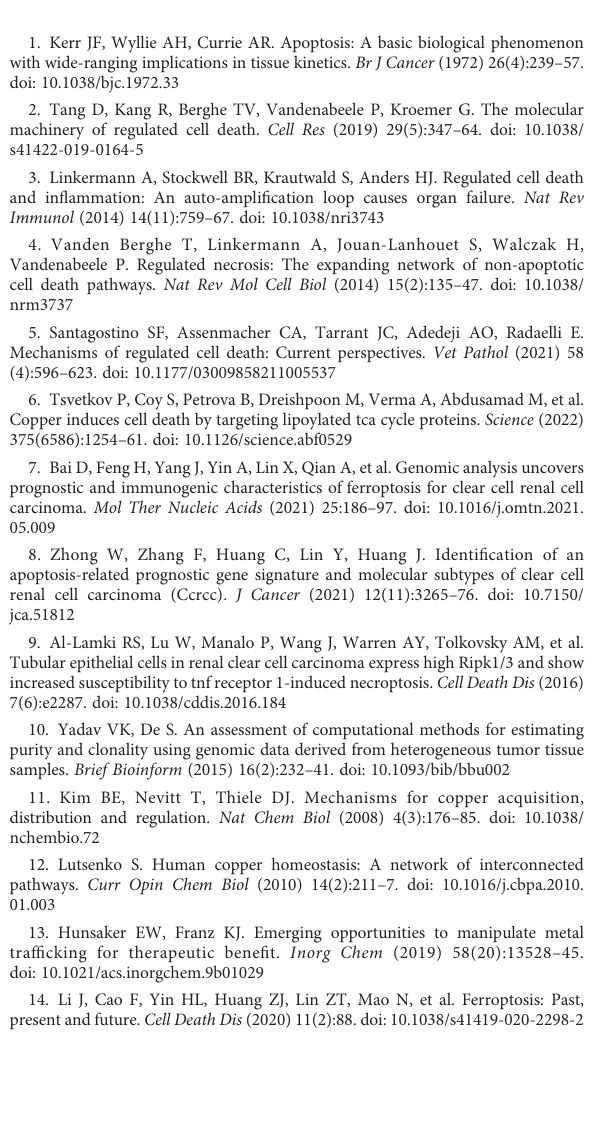
SUPPLEMENTARY FIGURE 1 The entire analytical process of the study. SUPPLEMENTARY FIGURE 2 (A, B) Results of enrichment analysis including GO and KEGG. (C) PFS curves of ccRCC patients with low and high cuproptosis score. PFS, progression-free survival. SUPPLEMENTARY FIGURE 3 (A) The cumulative distribution function (CDF) curves and (B) K-means ranging from 2-4 showed the proper gene clustering number was 3. (C) CAGs were remarkably dysregulated among subgroups. ( p < 0.05 *; p < 0.01 **; p < 0.001 ***). SUPPLEMENTARY FIGURE 4 (A) The cumulative distribution function (CDF) curves and K-means curve. (B) Heatmaps of consensus matrix depicting the possible clusters (k=2, 3, 4) and correlation areas. (C) Survival analyses on pRCC patients based on three ways of clustering. (D) Differential analyses on gene sets based on three ways of clustering. (E) Survival analysis on pRCC patients based on cuproptosis score. pRCC: papillary renal cell